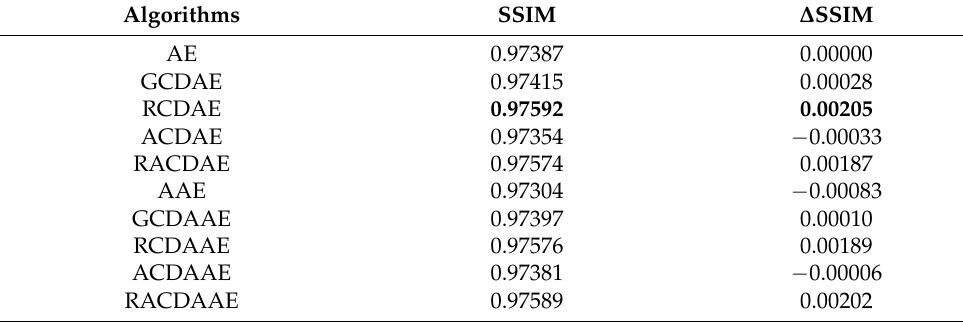
Table 5. Experimental results on the MNIST data set.